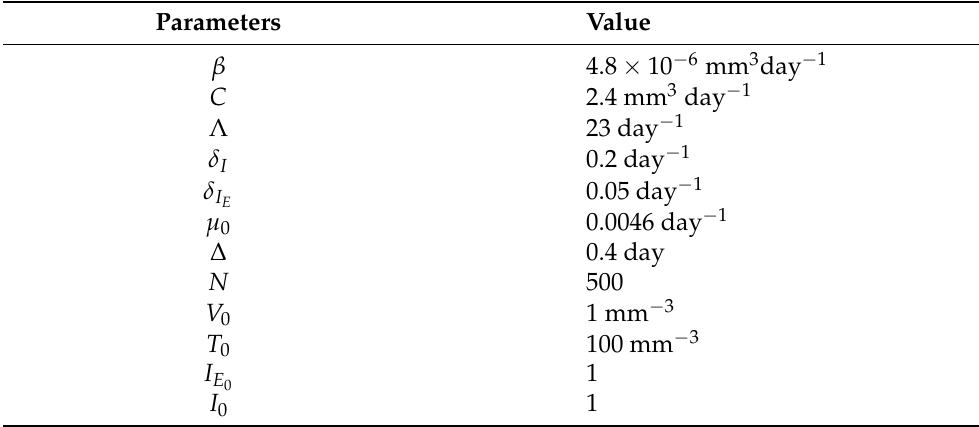
Table 2. Parameter values for the numerical simulations when R 0 > 1.